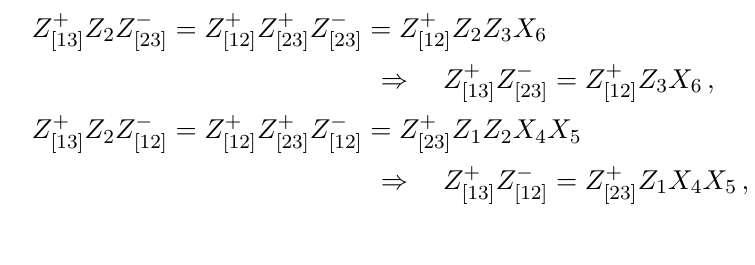
Figure 29 . Setups leading to the chiral ring relations: (a) Z + Z + Z 2 [13]